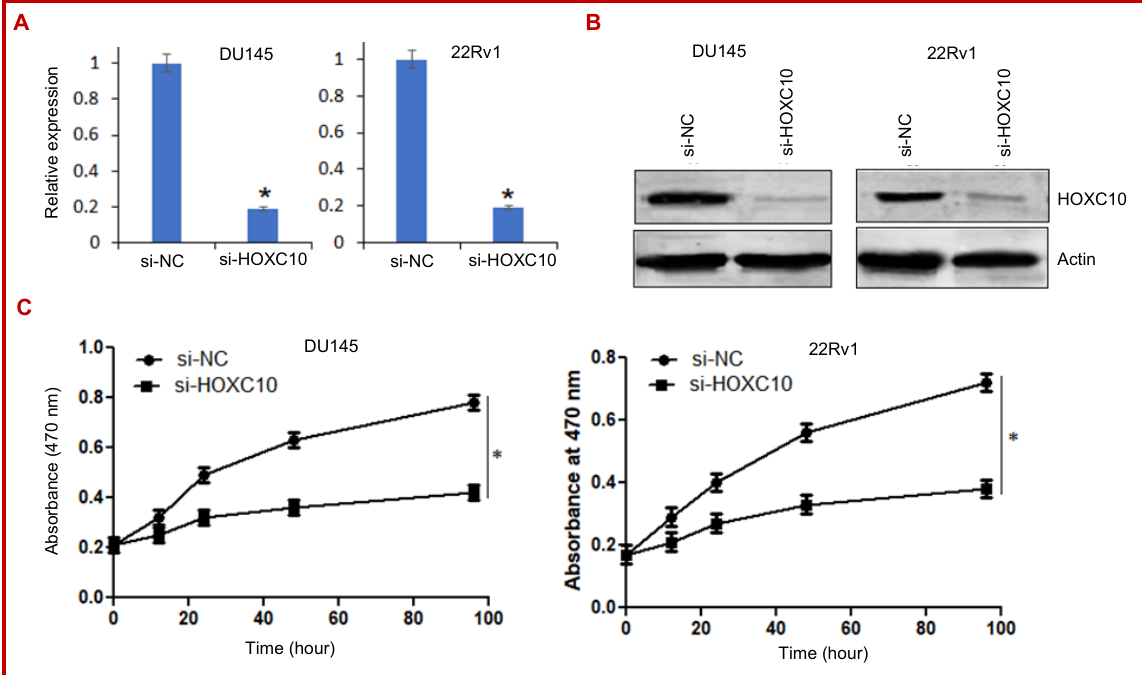
Figure 2: Transcriptional silencing of HOXC10 reduced the growth of prostate cancer cells effectively. (A) qRT-PCR expression of HOXC10 gene in DU145 and 22Rv1 prostate cancer cell lines transfected with si-NC or si-HOXC10; (B) Western blotting showing protein expression of HOXC10 gene in DU145 and 22Rv1 prostate cancer cell lines transfected with si-NC or si-HOXC10; (C) MTS assay showing proliferation of DU145 and 22Rv1 prostate cancer cell lines transfected with si-NC or si-HOXC10. The experiments were performed in triplicates and expressed as mean ± SD